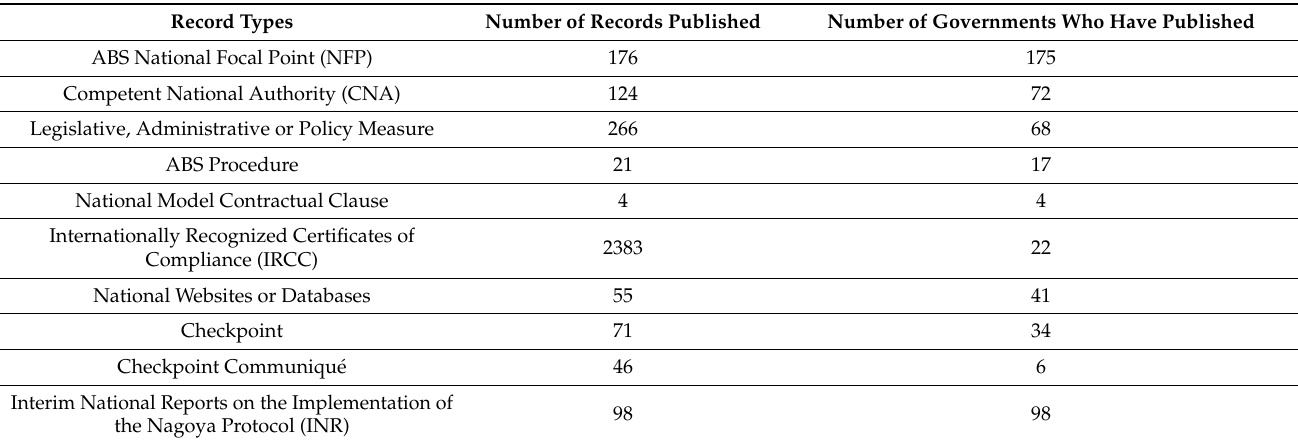
Table 1. National records available in the ABS Clearing-House (as of 19 June